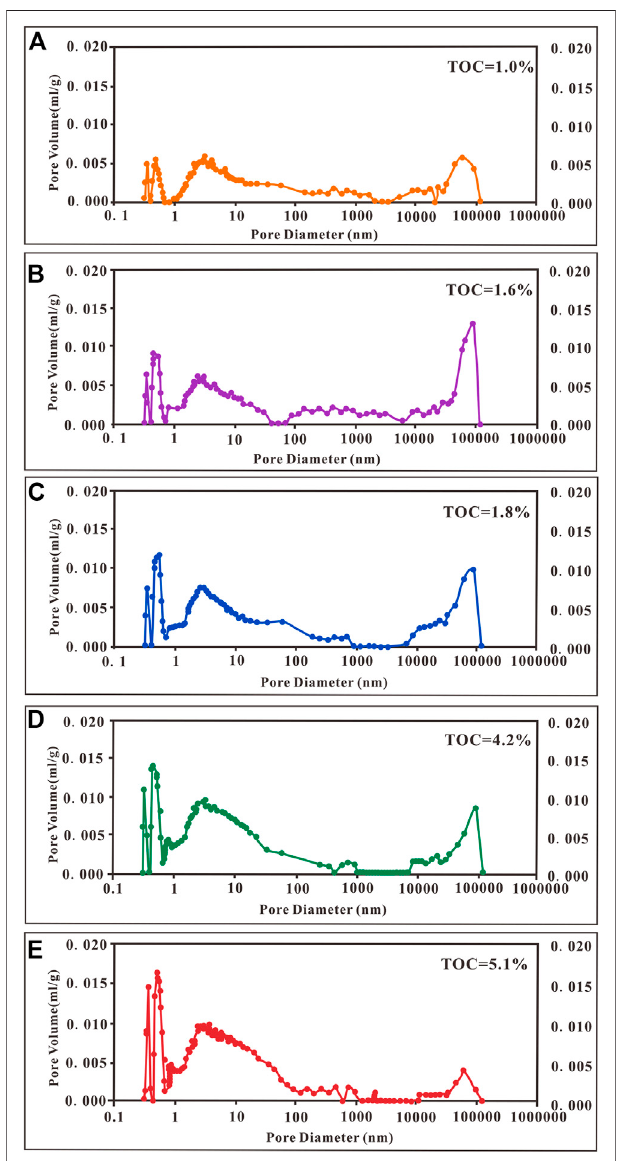
FIGURE 6 | The whole-aperture quantitative characterization on pore volume of the shales with different TOC content in JiaoYe 1 Well in the Long 1 Fm.: Characteristics about. (A) : 2337 m, TOC = 1.0%; (B) : 2358 m, TOC = 1.6%; (C) : 2369 m, TOC = 1.8%; (D) : 2396 m, TOC = 4.2%; (E) : 2406 m, TOC = 5.1%. See Figure 1 for the well location. Modi fi ed from reference (Tang et al., 2016).